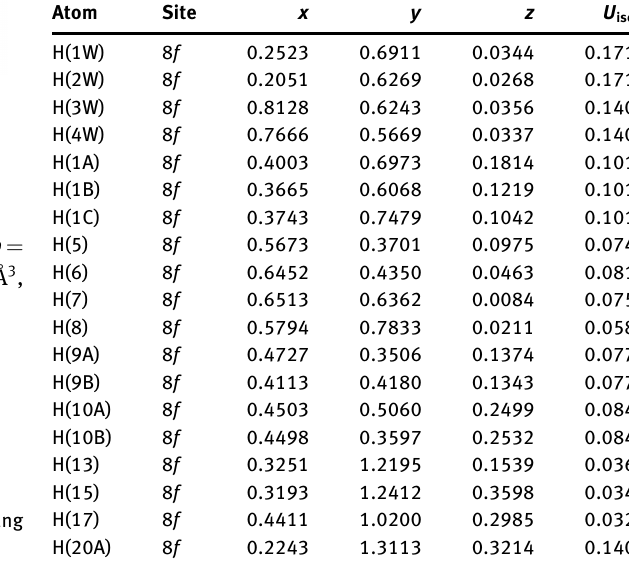
Table 2: Fractional atomic coordinates and isotropic or equivalent isotropic displacement parameters (Å 2